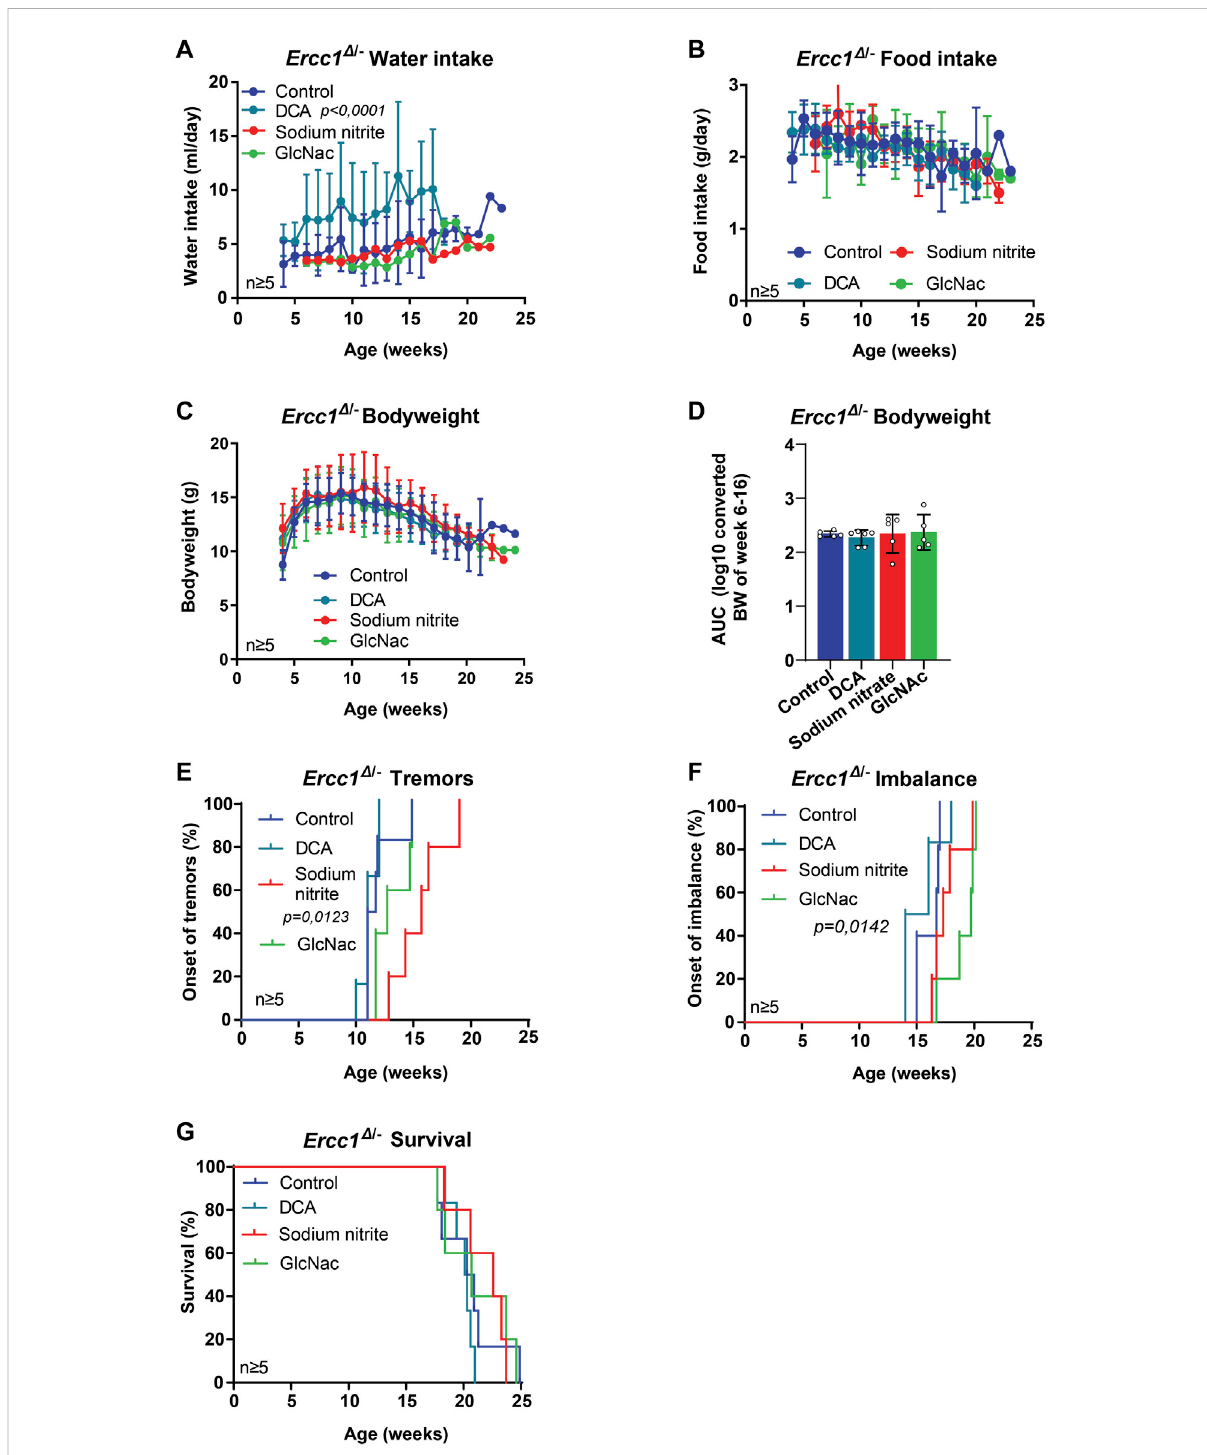
FIGURE 2 The effect of mitochondrial modi fi ers and GlcNAc supplementation on the lifespan and onset of neurological phenotypes of Ercc1 Δ / − mice. (A – D) , Comparison between Ercc1 Δ / − control mice and animals supplemented with sodium nitrite, DCA, or GlcNAc on water intake (A) , food intake (B) , bodyweight over time (C) and body weight as area under the curve (AUC) of measurements between 6 – 16 weeks (D) . (E – G) , Onset of neurological abnormalities; tremors (E) and imbalance (F) , and survival (G) of the same animals. Indicated values are Mean (±SD). Signi fi cant p values of the Dunnet ’ s multiple comparison test (A,E,F) are